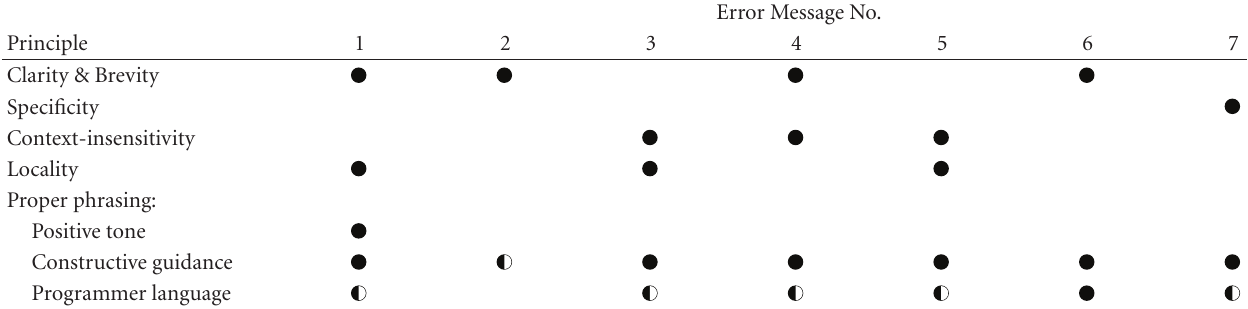
Table 2: Which principles are violated by which error messages (see Appendix A). indicates violation of the principle, whereas means the violation is less clear or to a lesser extent.